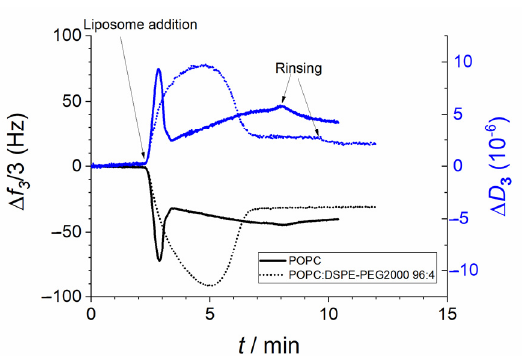
Figure 8. QCM-D signals (3rd overtone) obtained from the adhesion, rupture and spreading of POPC (solid line) and POPC:DSPE-PEG2000 (96:4 moL%—dotted line) liposomes on a silica surface at 21 °C.